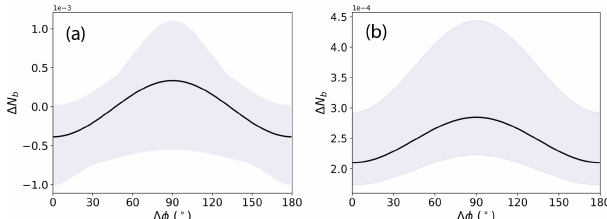
Figure 7. The change in buttressing number, (cid:49)N b , at and near to ice shelf thickness perturbations. In (a) , the change at the perturbation location is shown, and in (b) the mean change in all immediately neighboring cells is shown. Changes in buttressing are calculated along the direction (cid:49)φ , rotated counterclockwise relative to the n p1 direction. The points analyzed include those in Fig. 4a, which are shown as the shaded area, with the solid curve representing their mean